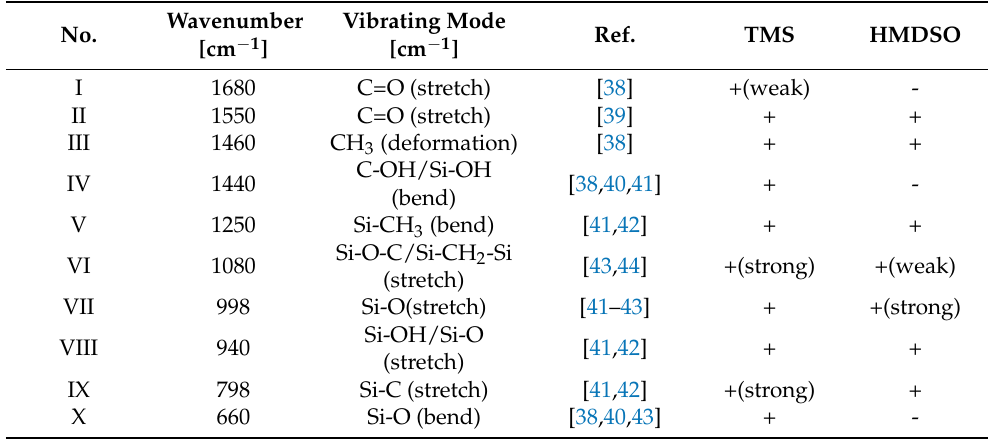
Figure 6. FTIR spectra of as deposited silicon-incorporated DLC coatings. Table 2. Characteristic IR absorption bands in the range 1800–600 cm − 1 for as deposited silicon-incorporated DLC coatings.